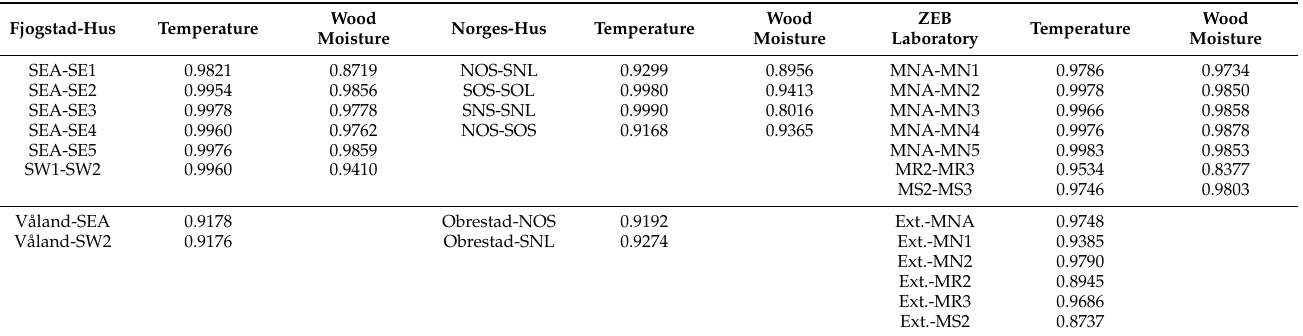
Table 4. A pairwise correlation between sensor data series. The “series” SEA is the average of the four series SE-1 to SE-5. Likewise, MNA is the average of MN1 to MN5. “Ext.” is the external temperature measured on site of the ZEB